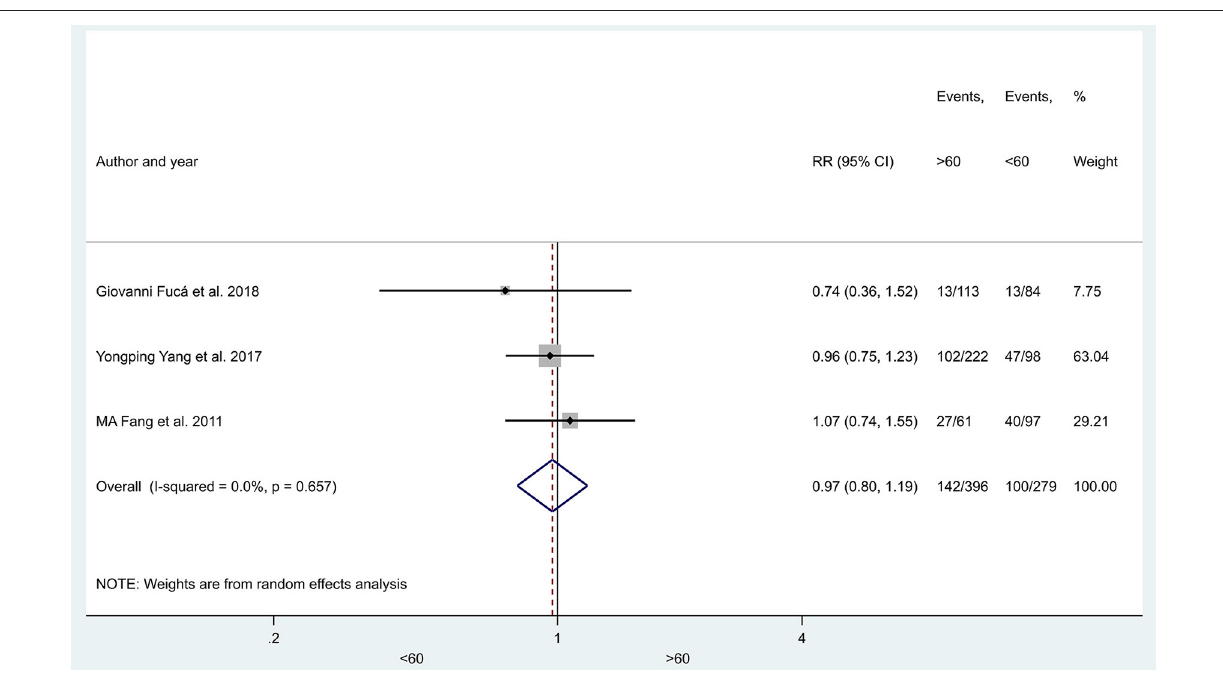
Frontiers in Medicine |